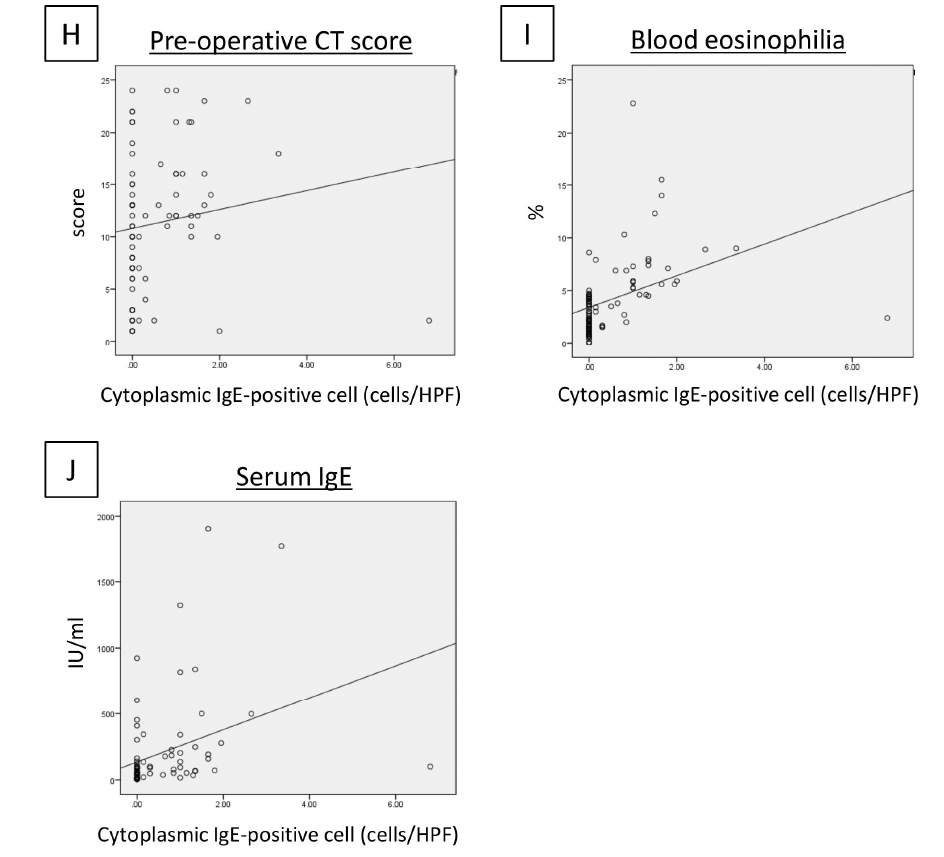
Figure 6. Lesion infiltration by cytoplasmic IgE-positive cells in each lesion. ( A ) non-CRS, ( B ) CRSsNP, ( C ) non-ECRS, ( D ) mild ECRS, ( E ) moderate ECRS, and ( F ) severe ECRS. ( G ) Cytoplasmic IgE-positive mast cells were significantly increased in moderate and severe ECRS lesions ( p < 0.05 and p < 0.01, respectively). Relationships between the number of cytoplasmic IgE-positive cells and the preoperative CT score ( H ), eosinophil ratio in peripheral blood ( I ), and total serum IgE level ( J